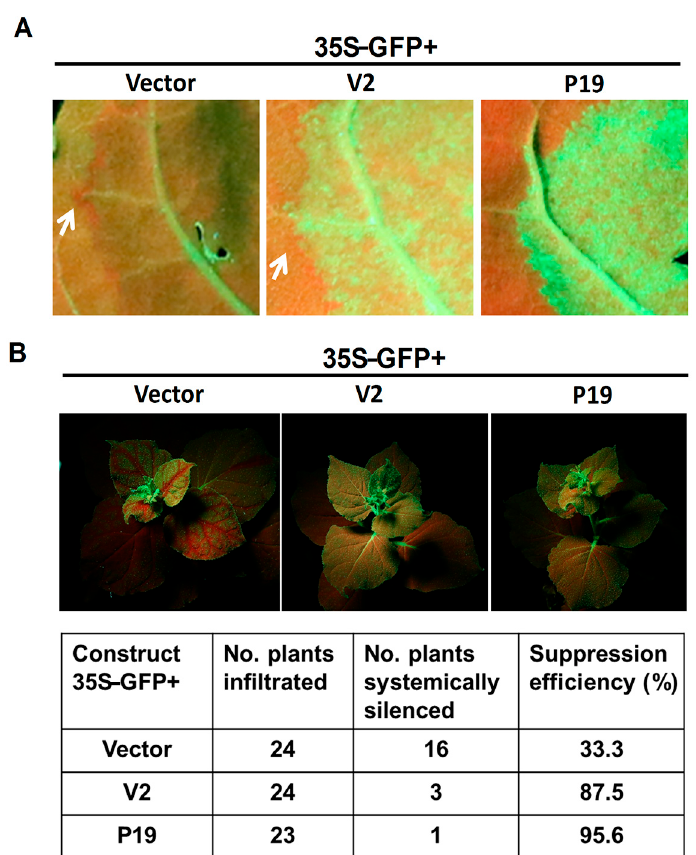
Figure 4. Effect of MMDaV V2 on short ‐ and long ‐ range spread of the silencing signals. ( A ) MMDaV V2 could not inhibit short-distance spread (10–15 cells) of the GFP silencing signal in N. benthamiana 16c plants. Leaves were infiltrated with a mixture of Agrobacterium cultures containing 35S-GFP and MMDaV V2. Leaves infiltrated with a mixtures of Agrobacterium cultures containing 35S-GFP plus the empty vector or 35S-GFP plus P19, served as negative or positive controls, respectively. Photographs were taken under UV light at 6 dpi. White arrows indicate the red ring, a hallmark of short-distance spread of the mobile RNA silencing signal at the edge of the infiltrated patches. ( B ) MMDaV V2 could interfere with systemic spread of RNA silencing signal in N. benthamiana 16c plants. The upper panels represent N. benthamiana 16c plants infiltrated with Agrobacterium cells carrying 35S-GFP plus empty vector (with systemic silencing), or 35S-GFP plus MMDaV V2 (with no systemic silencing), or 35S-GFP plus P19 (with no systemic silencing). Photographs were taken under UV light at 20 dpi. The number of N. benthamiana 16c plants systemically silenced at 20 dpi was indicated. N.